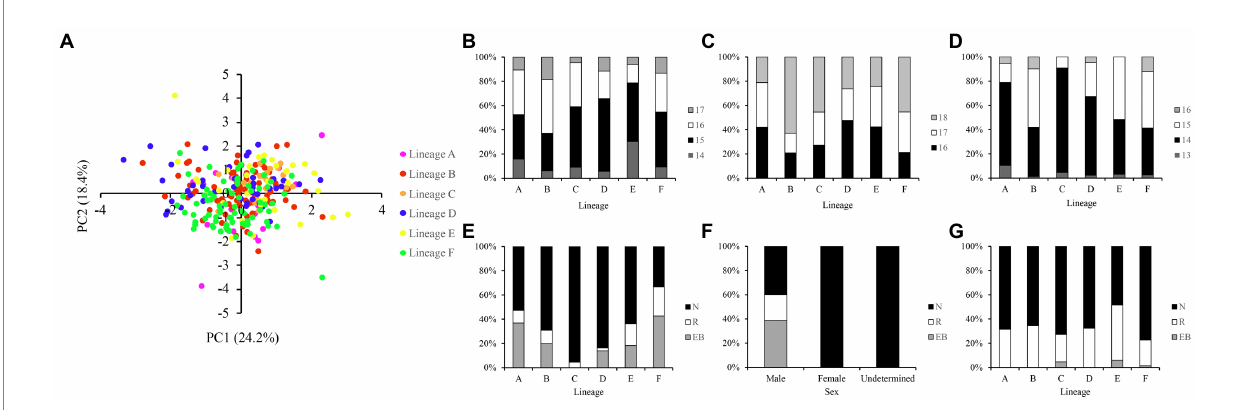
FIGURE 2 (A) Scatter plot of the first two principal components based on 20 measurements. The meristic counts differences between different lineages in (B) predorsal scales, (C) circumpeduncular scales, and (D) branched pectoral fin rays. The differences in the position of posterior end of pectoral fin against ventral fin origin between different (E) lineages and (F) sexes. (G) The differences in the position of the posterior end of maxilla against vertical of anterior margin of orbit. N, not reaching; R, reaching; EB, extend